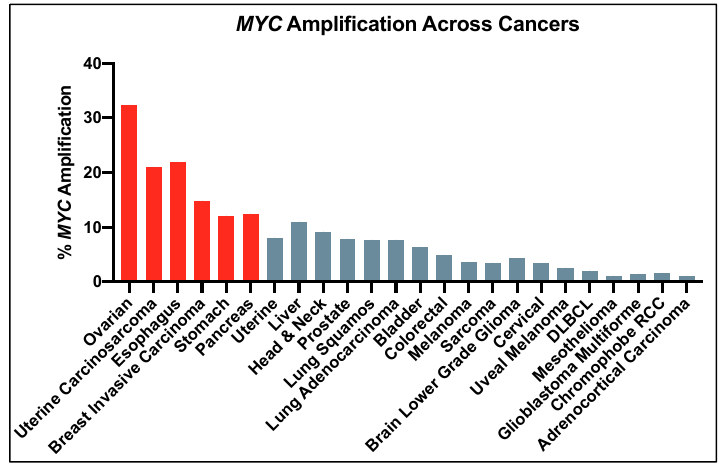
Figure 1. MYC amplification across cancers. Percentage represents number of patients with MYC amplification for that cancer type. Red bars represent cancers in which > 10% of patients harbor MYC mutations. Data from The Cancer Genome Atlas Pan Cancer 2018 Dataset, cancer.gov /